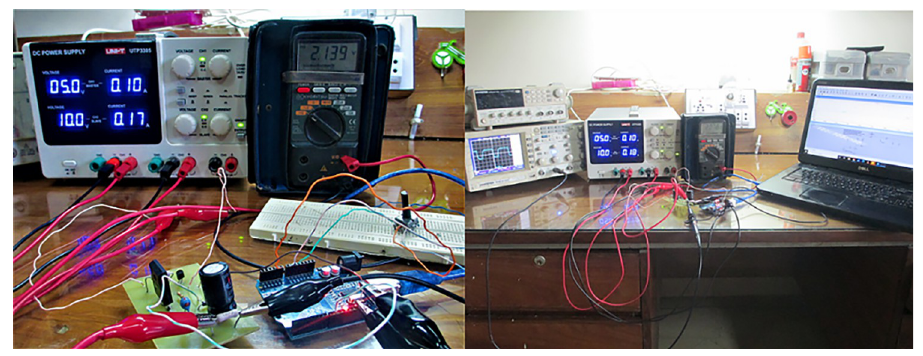
Fig 14. Experimental setup of sic-based buck convertor.